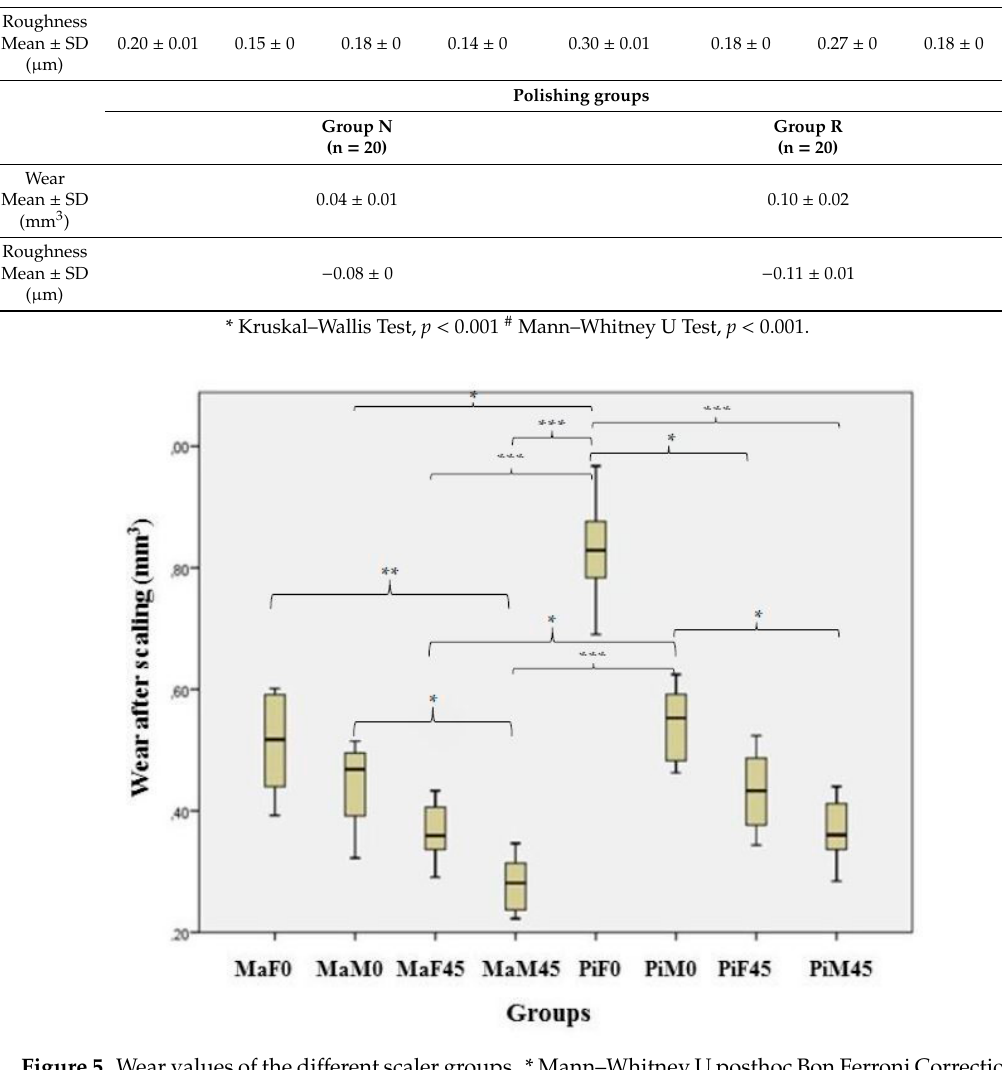
Table 2. Wear and roughness of di ff erent ultrasonic scalers and polishing groups.